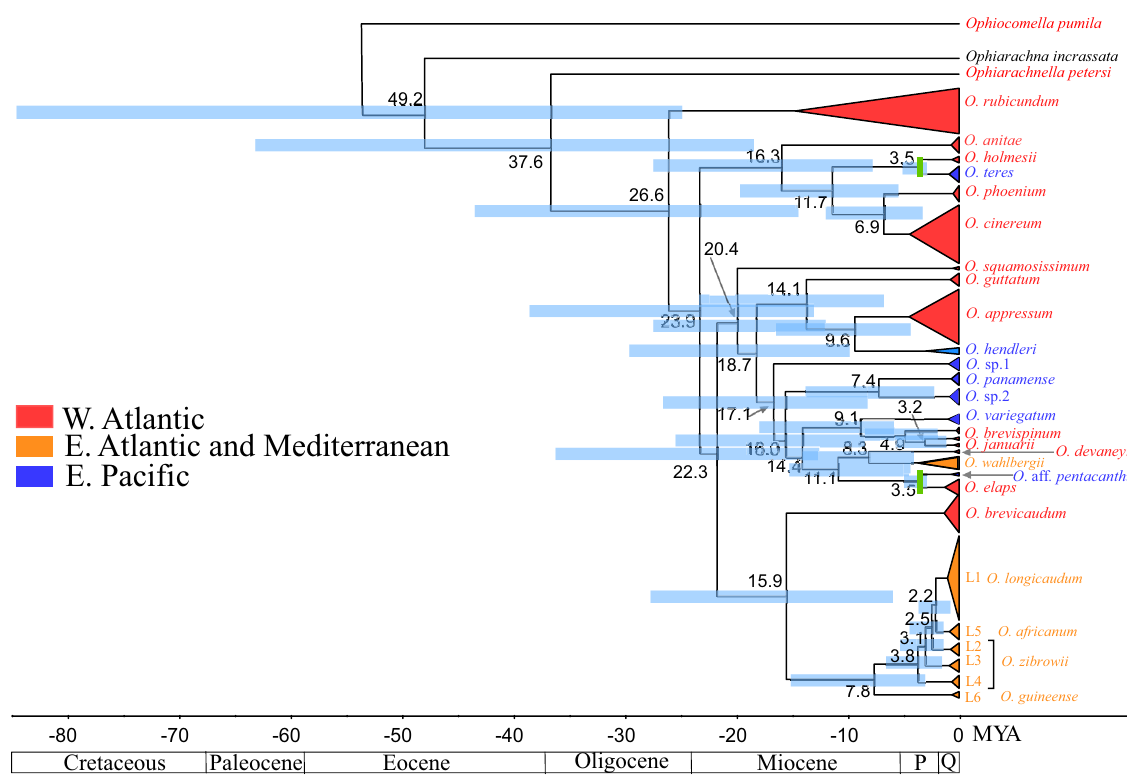
Figure 3. Chronogram of Ophioderma generated by BEAST v. 1.10.4 111 , showing median and 95% Highest Posterior Density (HPD) times of divergence between the clades. A log-normal uncorrelated relaxed clock was calibrated with an exponential prior that assumes that the minimum time of splitting between O. holmesii and O. teres and also between O. elaps and O . aff . pentacanthum (marked with green bars) was the completion of the Central American Isthmus 3 million years ago. Numbers next to nodes indicate median estimates of divergence